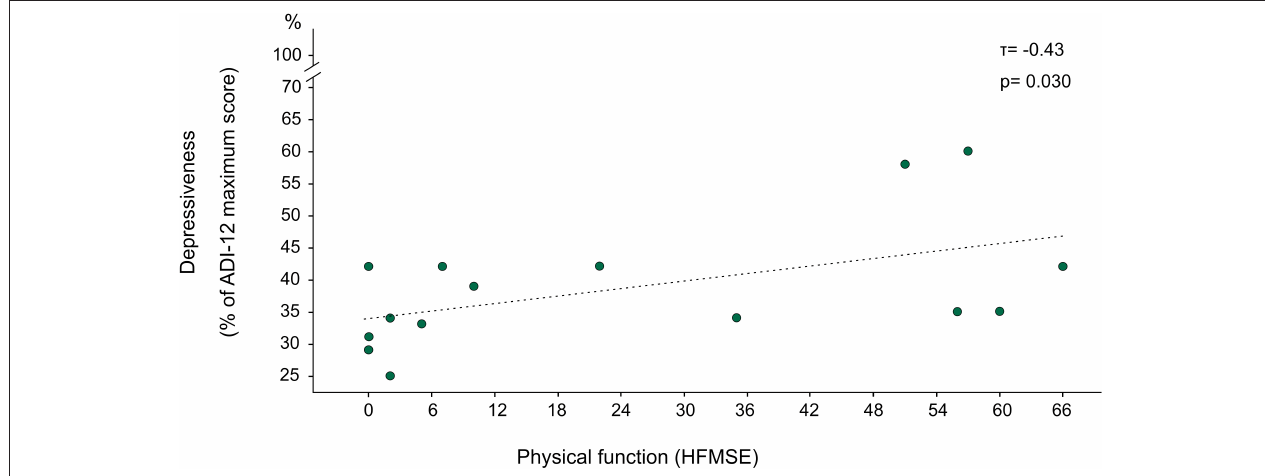
FIGURE 3 | Association of depressiveness with physical function. N = 15; Depressiveness was evaluated with ALS Depression Inventory 12 (ADI-12), where the original scale from 12 to 48 was transformed into percentual values of the maximum score, yielding a scale from 25 to 100%. Physical function was evaluated with Hammersmith Functional Motor Scale Expanded (HFMSE) with values from 0 (minimum physical function) to 66 (maximum physical function); lower depressiveness was significantly associated with lower physical function ( τ = − 0.43, p =